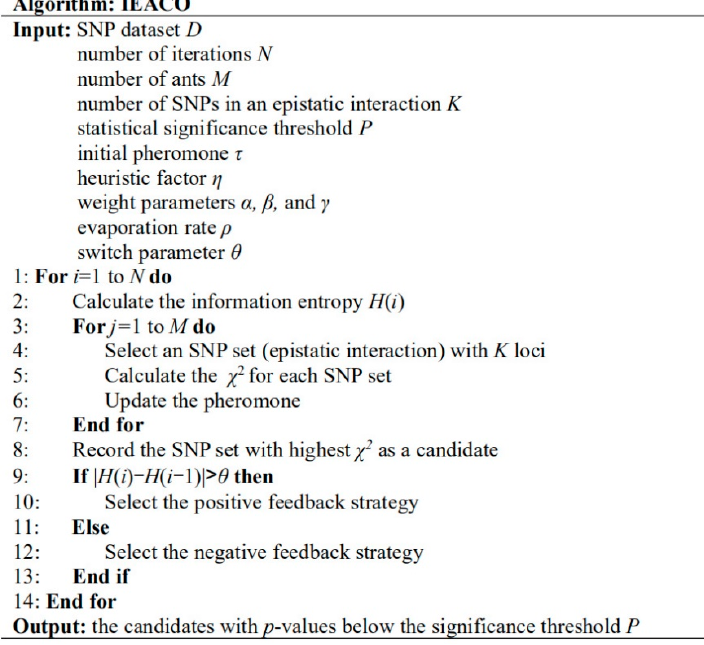
Figure 1. Pseudocode of ant colony optimization based on information entropy (IEACO) to solve epistatic interactions.